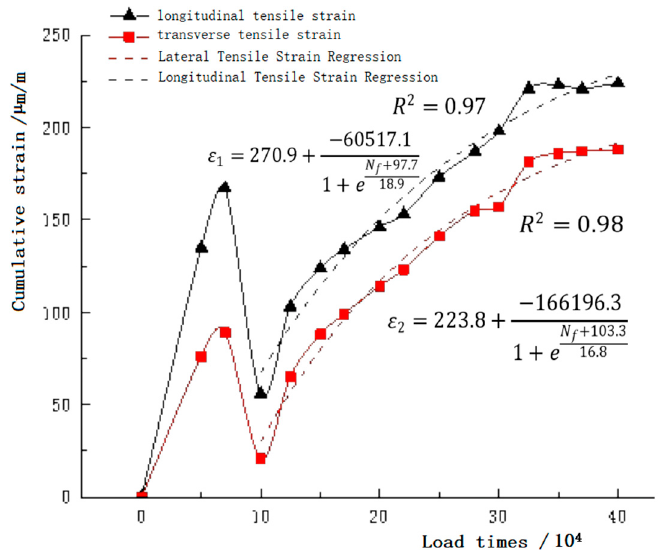
Figure 11. Cumulative strain versus number of load actions.